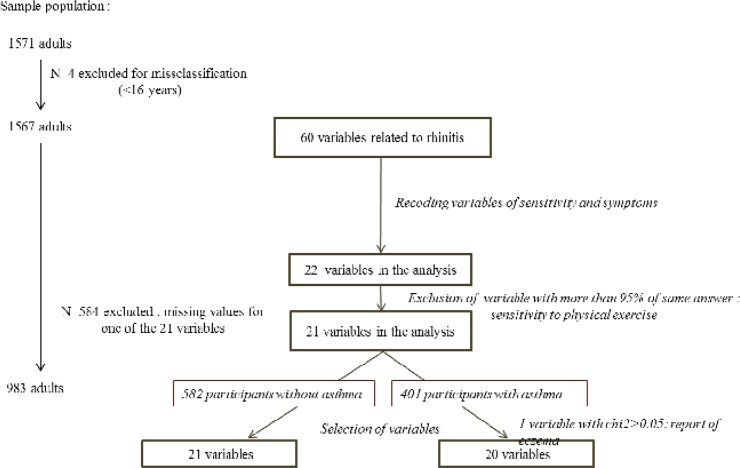
Flow-chart of the variables and of the participants included in the analysis.